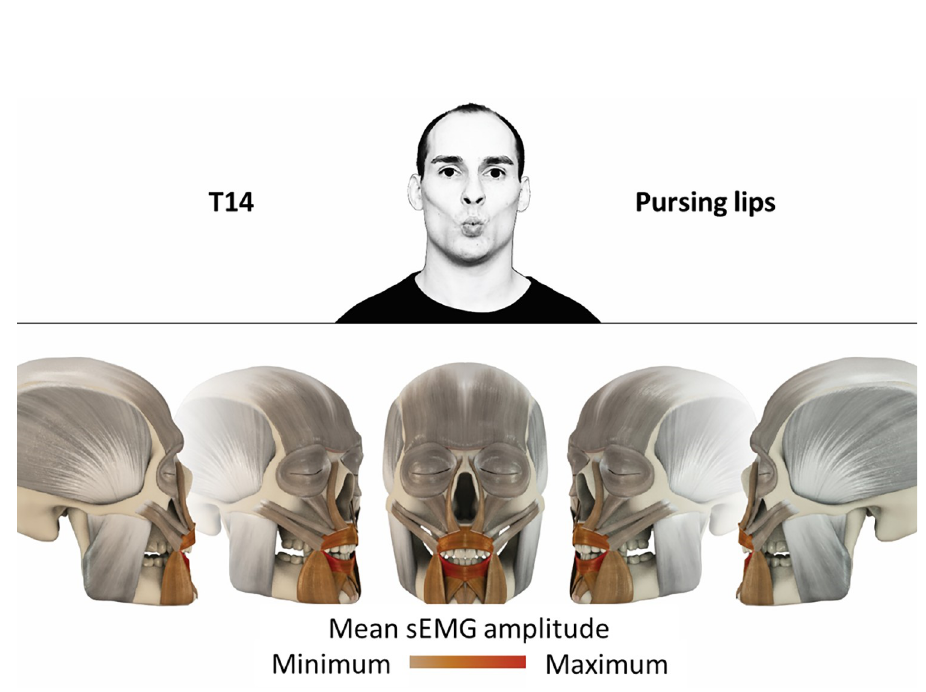
Fig 15. Color-coded facial muscle activation pattern of task T14. Pursing lips. Animation by Jonas Laustro¨er.